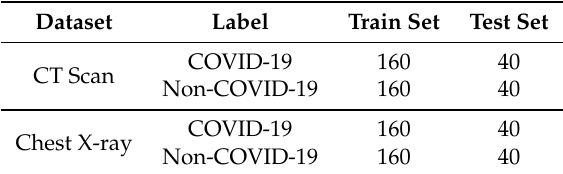
Table 1. Chest CT and X-ray datasets used in this